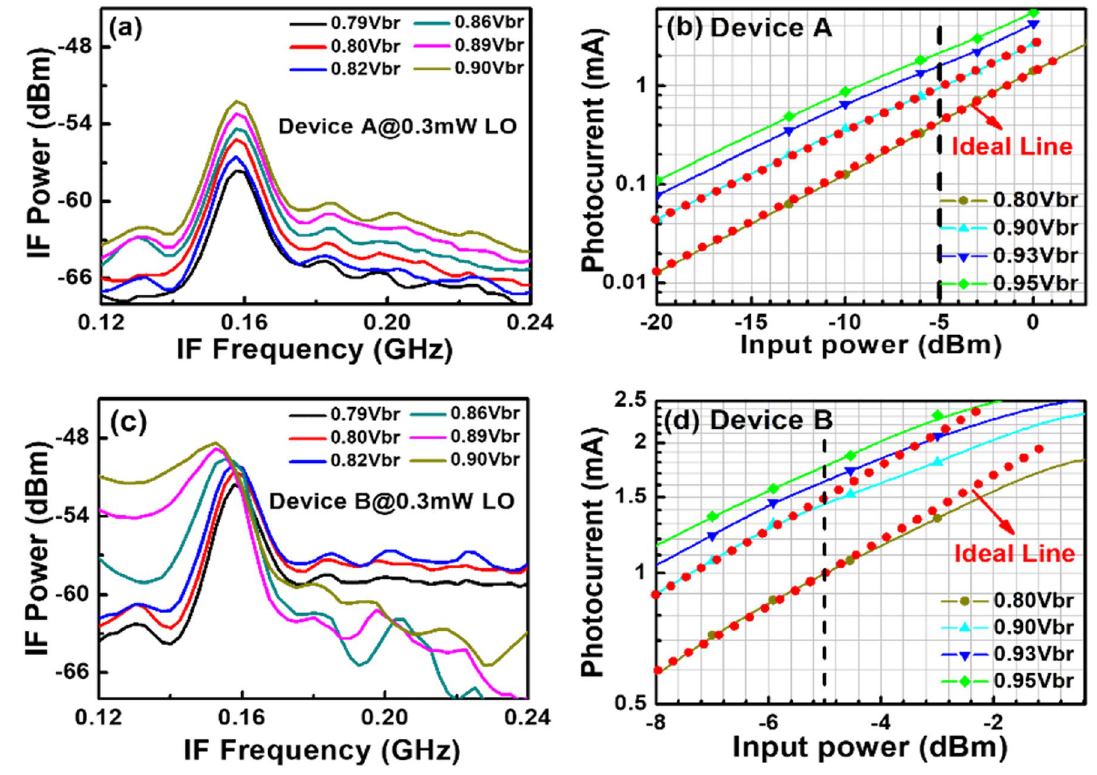
Figure 11. ( a ), ( c ) shows measured bias dependent IF spectra at a fixed 0.3mW LO power for Device A and Device B. ( b ), ( d ) shows the close-up versions of Fig. 8a,c, respectively.